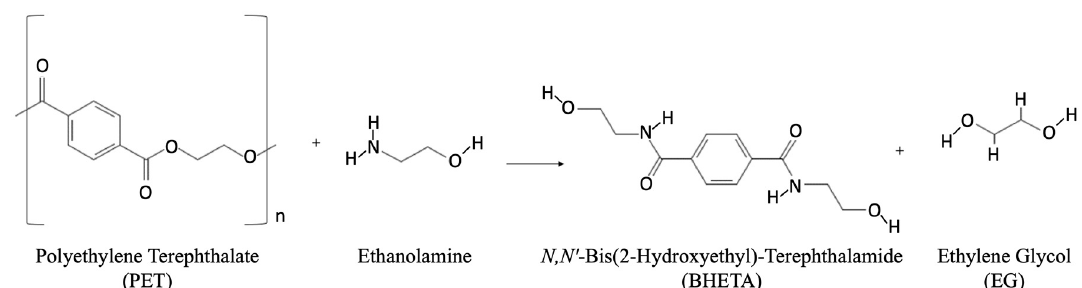
Figure 10. Aminolysis process chemical reaction for depolymerization of